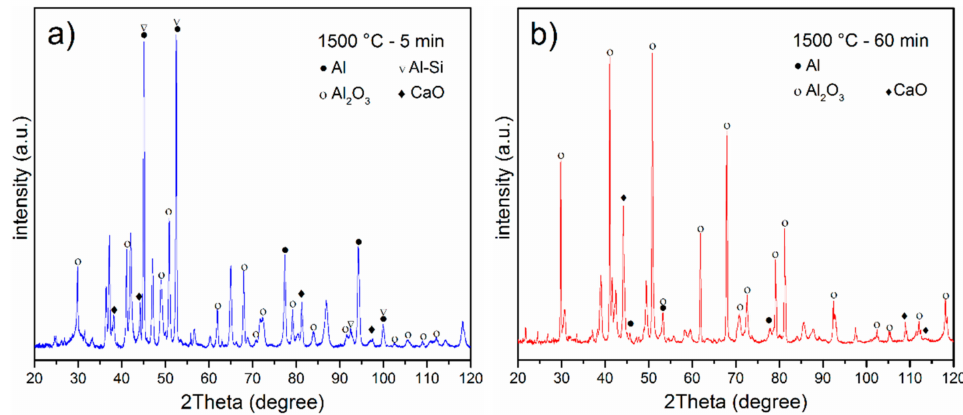
Figure 5. XRD patterns of annealed metallized paper at 1500 ◦ C after ( a ) 5 and ( b ) 60 min.